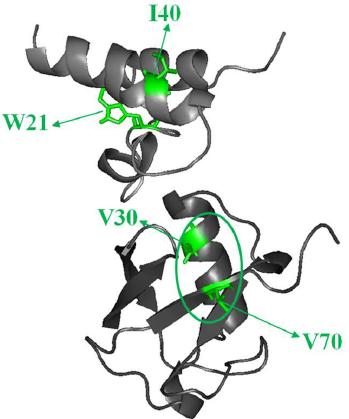
Figure 8. The hydrophobic residues that are perturbed in the interaction between CUBAN and NEDD8, as revealed by the 15 N HSQC perturbation map, are mapped on the cartoon representation. Residues were selected among those perturbed in the interactions of labeled CUBAN with NEDD8 (15:1) and of labeled NEDD8 with CUBAN (1:5).